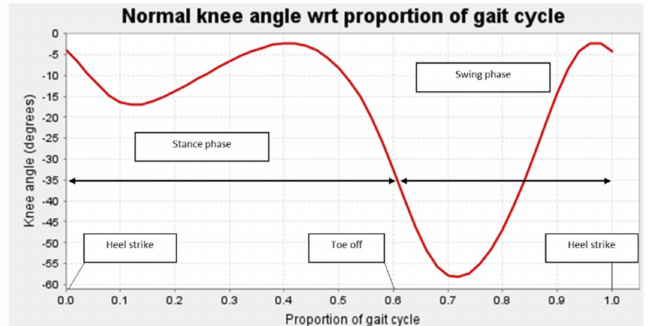
Figure 1. Normal knee angle (red curve) by phase of gait cycle with respect to proportion of gait cycle. The black arrows represent the duration of the stance phase from 0.0 to 0.6 proportion of the gait cycle, and the swing phase from 0.6 to 1.0 of the gait